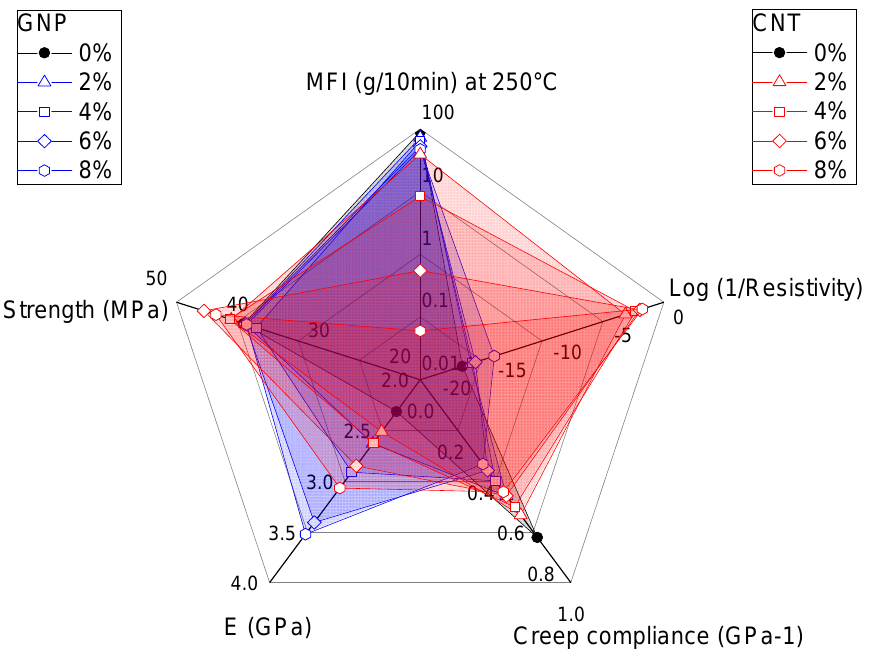
Figure 13. Comparison of selected properties of ABS/GNP and ABS/CNT nanocomposites as function of nanofiller fraction (2–8 wt %).